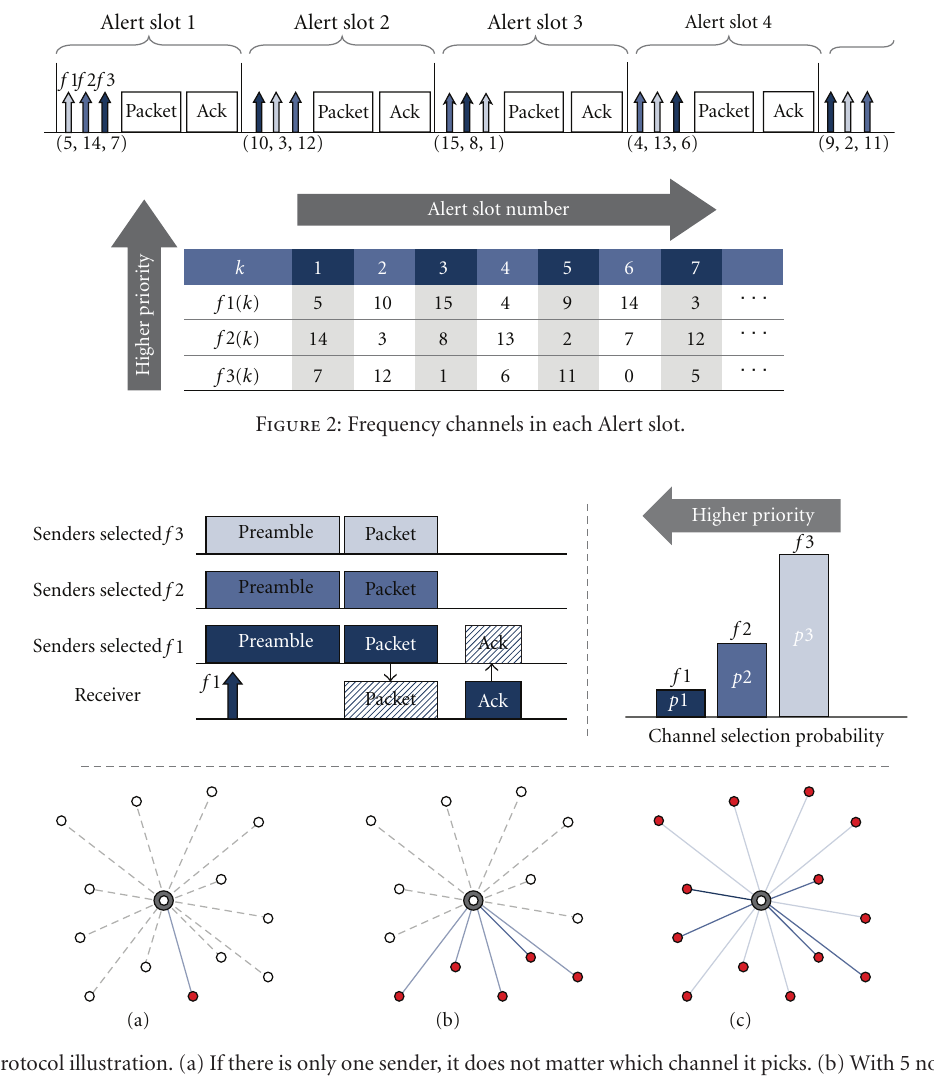
the probability distribution over the channels that minimizes the overall time to read all messages. A larger